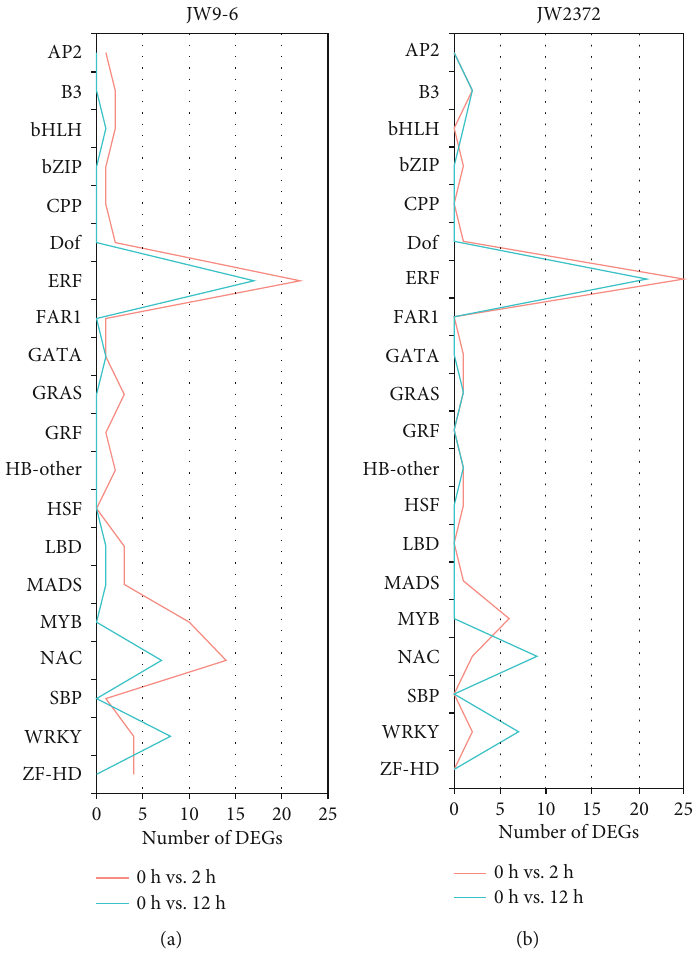
Figure 5: Prevalence of di ff erentially expressed transcription factor families after salinity stress. (a) DEGs encoding transcription factors in JW9-6. (b) DEGs encoding transcription factors in JW2372. Only transcription factor families with more than one DEG between any comparison are